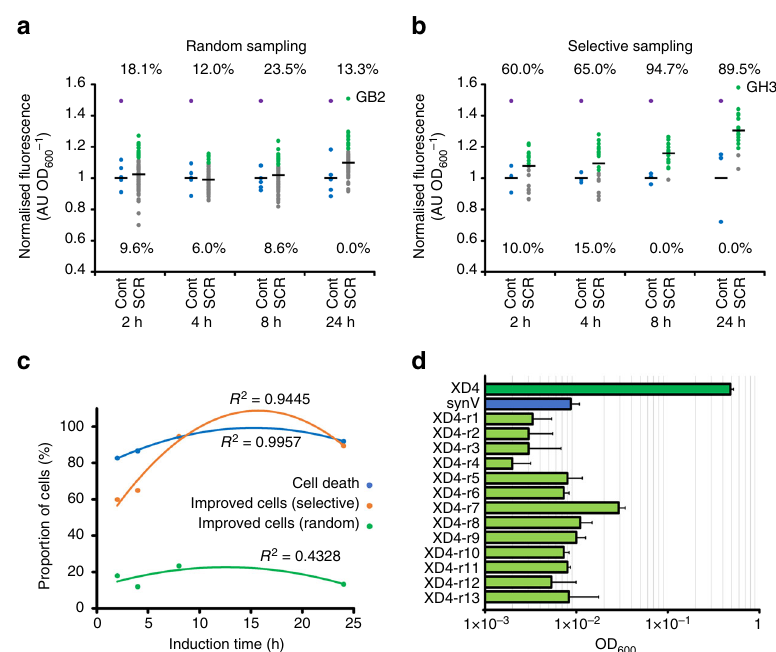
Fig. 4 Investigating the dynamics of SCRaMbLE. a The endpoint 520nm fl uorescence values of SCRaMbLEd synV-pBAB016 colonies picked randomly after 2, 4, 8 or 24 h of β -estradiol induction and then grown in 96-well plate format for 24 h. For each induction length, ≥ 81 randomly selected induced colonies were characterised and 6 colonies were also characterised from an uninduced synV-pBAB016 control plate. Fluorescence values were normalised for culture OD 600 and are given as a proportion of the mean un-SCRaMbLEd control fl uorescence value for that induction length. Blue dots denote un- SCRaMbLEd controls (cont), grey dots denote SCRaMbLEd cells (SCR) that have a fl uorescence value equal to or lower than the highest un-SCRaMbLEd control, green dots denote SCRaMbLEd cells that have a higher fl uorescence values than any of the un-SCRaMbLEd controls and purple dots denote the relative VB2-pBAB016 fl uorescence value from Fig. 1e. Percentage values above the plotted data are the proportion of SCRaMbLEd cells that have a higher fl uorescence value than any of the un-SCRaMbLEd controls and values below the plotted data give the proportion of SCRaMbLEd cells with a lower fl uorescence value than those controls. Black horizontal lines denote the mean average relative fl uorescence of that group of cells, excluding the VB2- pBAB016 value in the case of the controls. b The equivalent information but with SCRaMbLEd colonies visually screened under blue light to selectively pick colonies with high fl uorescence. For each induction length, ≥ 19 selected colonies were characterised along with 3 un-SCRaMbLEd controls. c For each induction length, the proportion of cell death and the proportion of improved cultures, i.e., those with higher fl uorescence output than any of the equivalent un-SCraMbLEd controls, with either selective or random picking of colonies. Lines are second-degree polynomial curves of best fi t, with R 2 values stated. d OD 600 achieved after 48 h growth in synthetic xylose medium of XD4-pJCH006, synV-pJCH006 and the 13 fastest growing re-SCRaMbLEd